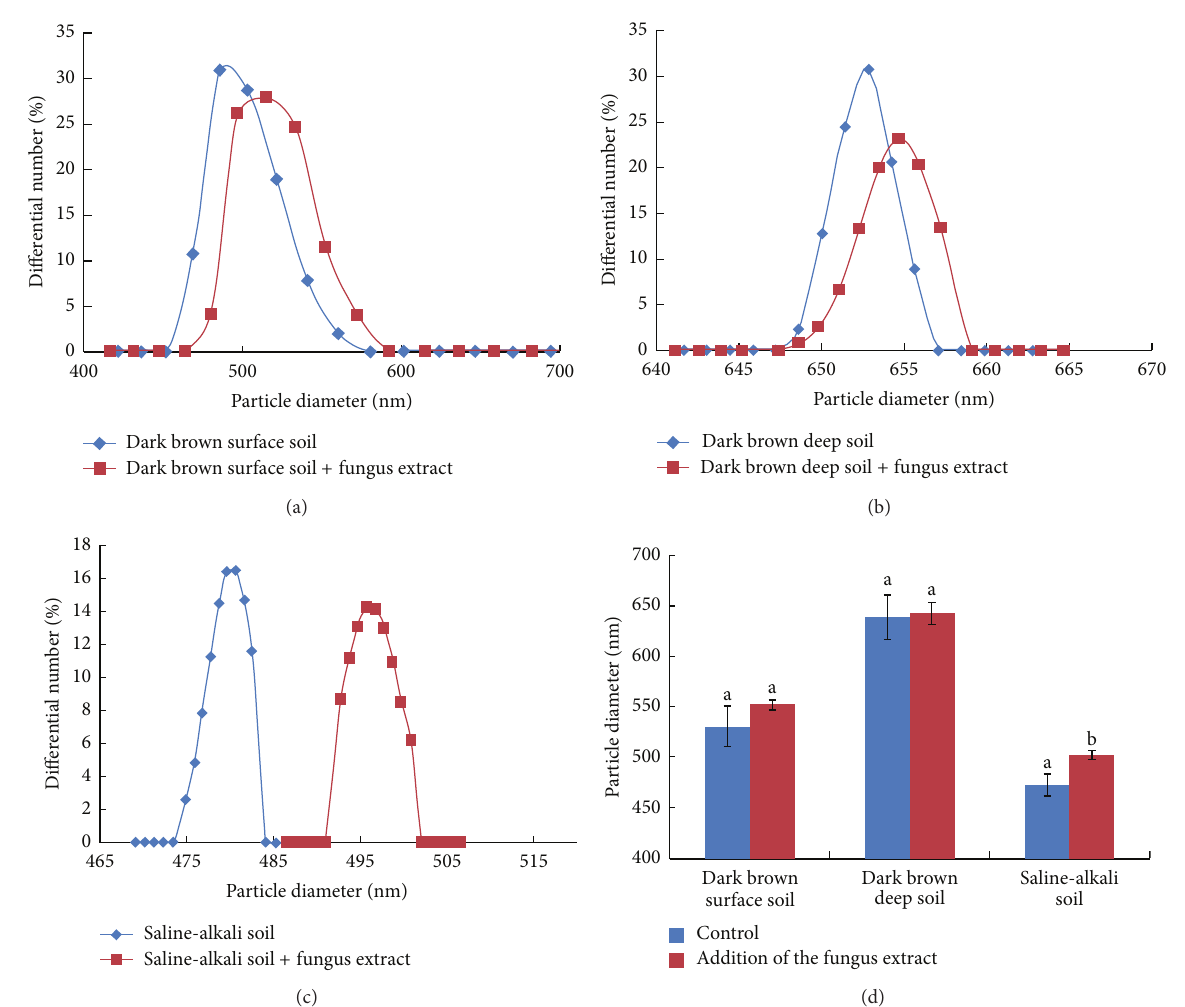
Figure 1: Particle diameter changes in soil colloids with and without fungus extract